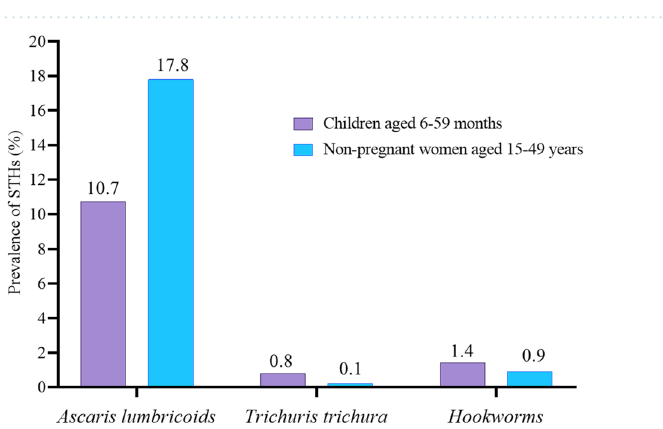
Table 2. Socio-demographic and health characteristics of children aged 6–59 months by status of soil transmitted helminths, Nepal National Micronutrient Status Survey, Nepal, 2016. Ns are unweighted. Values presented are mean (95% CI) or percent (95% CI). All estimates account for weighting and complex sampling design. AGP, ɑ -1 acid glycoprotein; CI, confidence interval; CRP, C-reactive protein; RBC, red blood cell; RBP, retinol binding protein. a Haemoglobin adjusted for altitude and smoking 28 . b Anaemia defined as altitude- and smoking-adjusted Hb < 12.0 g/dL 28 . c Receiving deworming during the 6 months preceding the survey. d Iron deficiency defined as inflammation-adjusted serum ferritin < 15.0 μg/L 28 . e Vitamin A deficiency was defined as RBP < 0.64 μmol/L 28 . f Folate cutoff based on the risk of megaloblastic anaemia defined as RBC folate < 305.0 nmol/L 28 . g Zinc deficiency defined as serum zinc < 65.0 μg/dL for nonfasted, morning (i.e. before 12 pm) samples and < 57.0 μg/dL for non-fasted, afternoon (i.e. after 12 p.m.) samples, inflammation adjusted 28 . h Soil-transmitted helminths including hookworm, T. trichura , and A. lumbricodes.